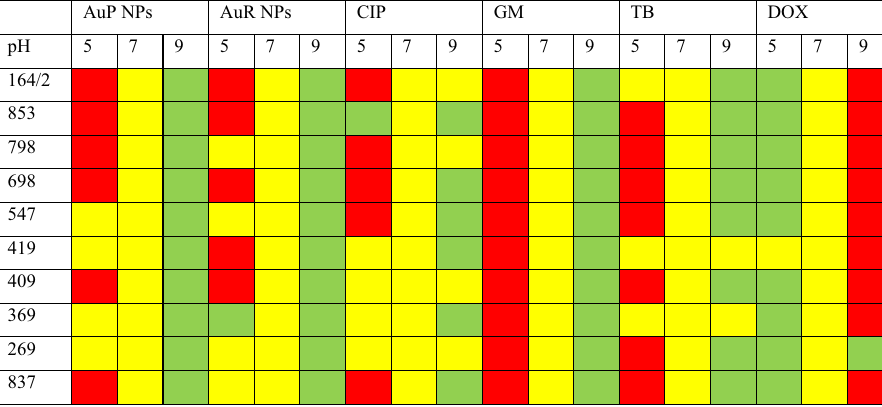
Table 2. Alterations in peanut- and rod-shaped gold nanoparticles killing activity when tested in growth medium with different pH values compared to conventional antibiotics. Graph was constructed by comparing MIC values recorded for indicated clinical isolates of E. coli in LB adjusted to 5, 7 or 9 pH. MIC value in LB (pH = 7; yellow color) was the reference point for further comparisons. Red and green color indicate the rise or drop in MIC value, respectively. CIP ciprofloxacin, GM gentamicin, TB tobramycin, DOX